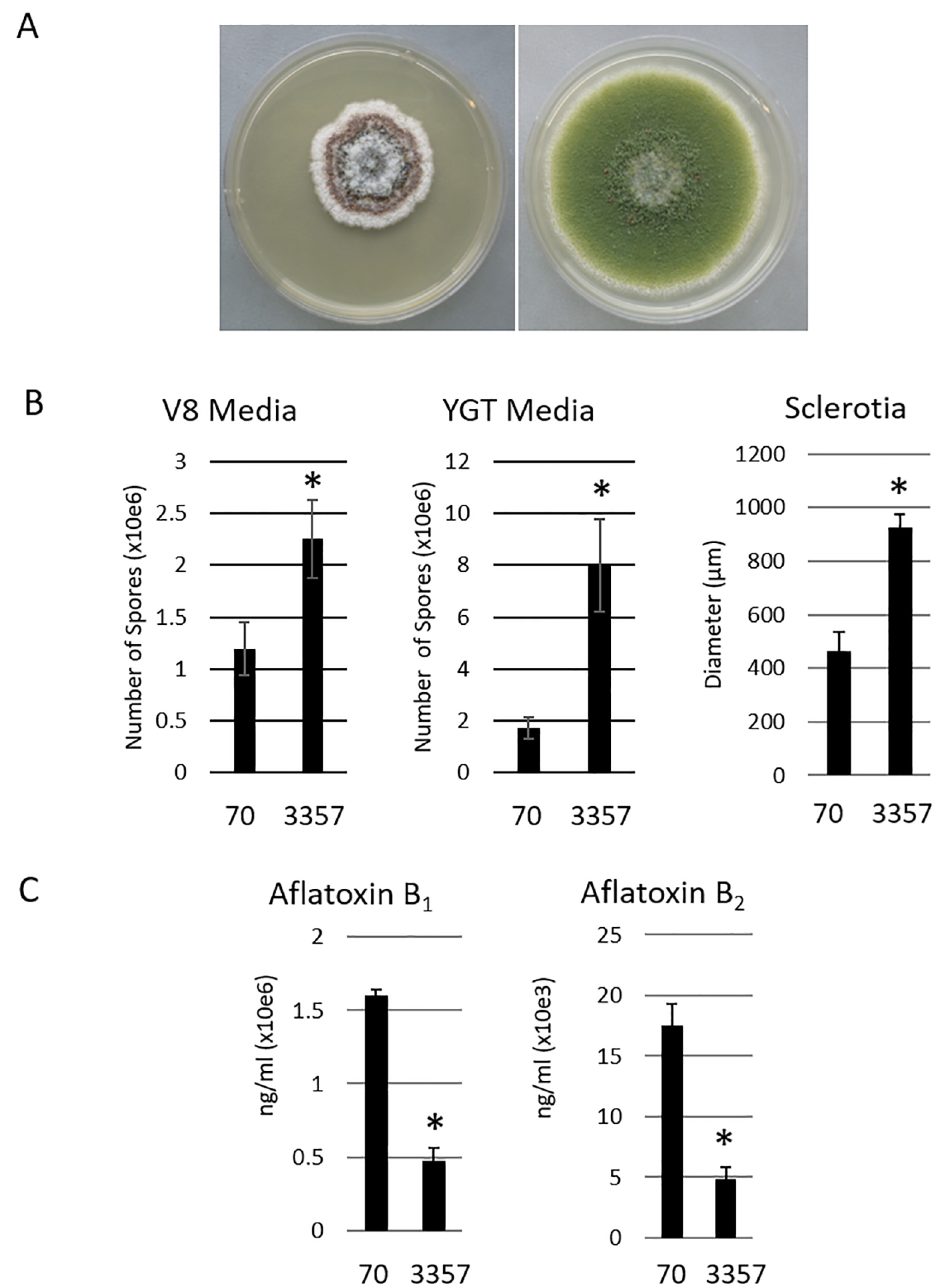
Fig 1. Phenotype comparisons for A . flavus strains AF70 and NRRL 3357. A) After 6 days growth on YGT media, S- morphotype AF70, left, demonstrated several rings of pigmentation correlating with production of numerous small sclerotia, with unpigmented hyphae in the outermost edges of growth. Conversely, L-morphotype NRRL 3357 maintains typical olive-green pigmentation with no sclerotia visible. B) Spore production on two media types, V8 and YGT showed NRRL 3357 consistently producing more spores. C) HPLC quantification of aflatoxin AFB production shows higher concentrations produced by S-morphotype AF70. Student’s t-test where P (cid:20) 0.05 indicated by asterisk ( (cid:3) ).